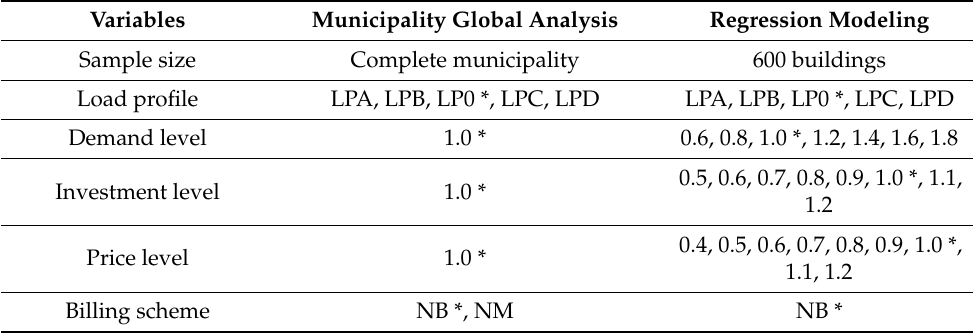
Table 5. Simulation scenarios for the development of